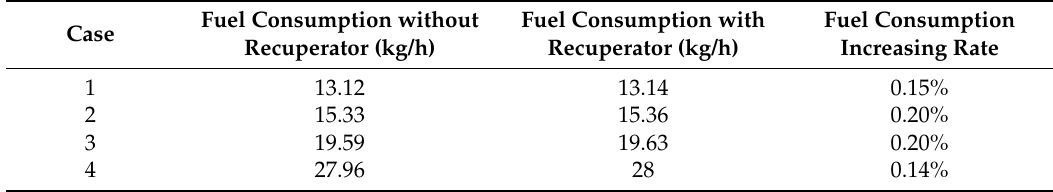
Table 5. Comparison between fuel consumption without and with the recuperator.